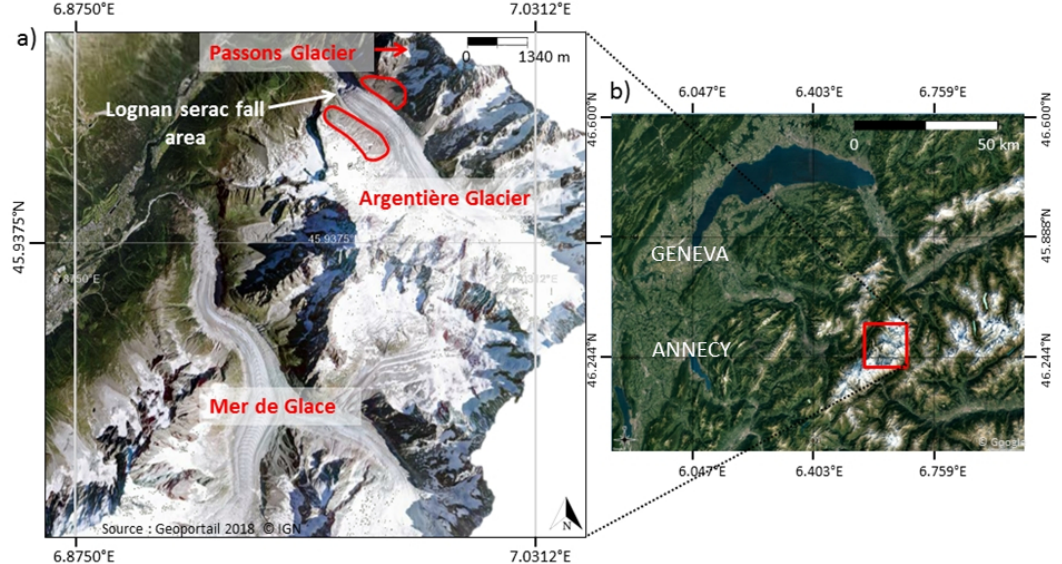
Figure 8. ( a ) map showing Argentière and Mer de Glace glaciers; ( b ) overview map showing location of Chamonix–Mont-Blanc test site.